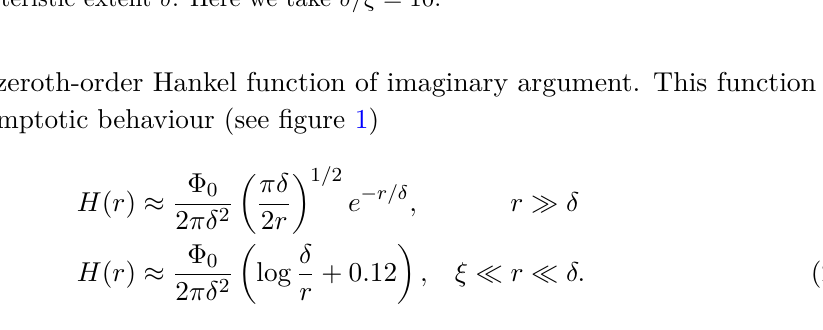
Figure 1 . The field profile of an isolated vortex. The blue line is the profile of the radial mode | Φ( r ) | , which has a characteristic extent ξ , while the red line is the profile of the magnetic field, which has a characteristic extent δ . Here we take δ/ξ = 10